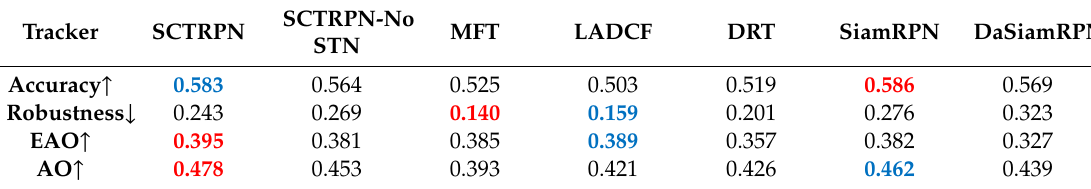
Table 3. Comparison with the state-of-the-art in terms of accuracy, robustness (failure rate), expected average overlap (EAO) and no-reset-based average overlap (AO) on the VOT2018 dataset. The best two results are highlighted in red and blue fonts, respectively.